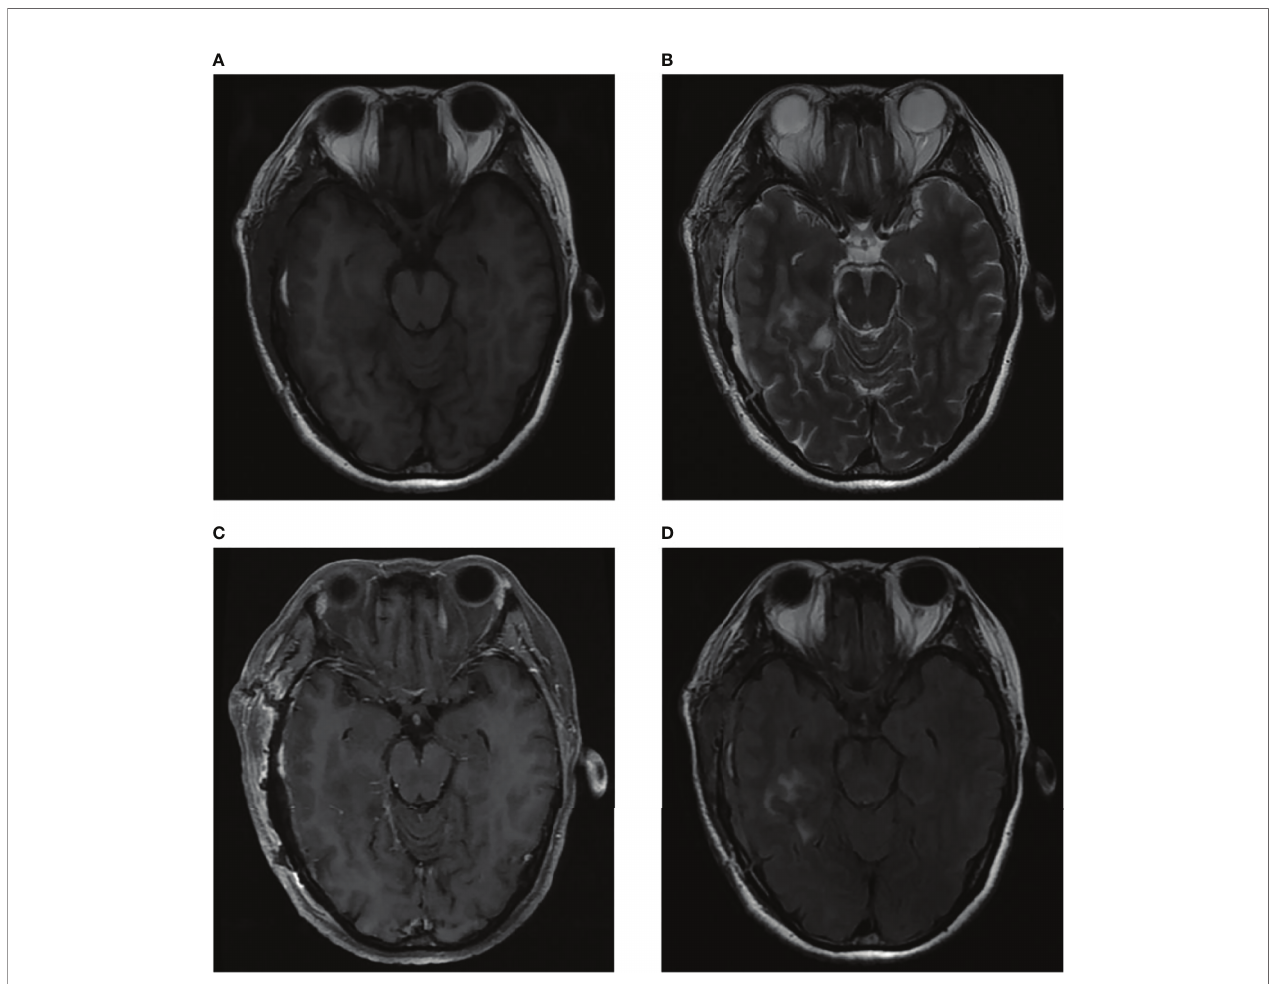
FIGURE 4 | Postoperative brain MRI indicated abnormal long T1-weighted and long T2-weighted signal (A, B) in the right part of the pons, which showed high signal on FLAIR imaging (D) and no enhancement of the lesion on contrast-enhanced imaging (C)